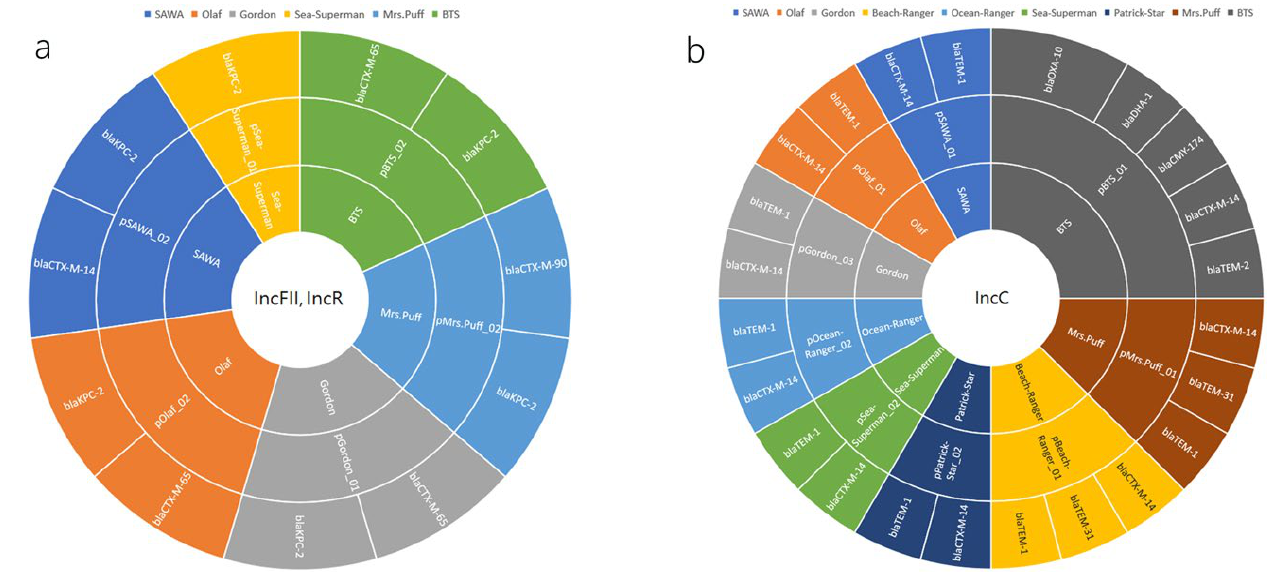
Figure 4. The correlation between plasmid groups and associated β -lactamases identified in the CRKP. The figure shows the frequency of different β -lactamase genes in relation to the plasmid groups IncFII/IncR ( a ) and IncC ( b ) groups. bla KPC-2 carriage is enriched with plasmids belonging to IncFII /Inc R group. bla TEM carriage is frequently found on plasmids belonging to IncC group, while bla CTX-M appears in both plasmid